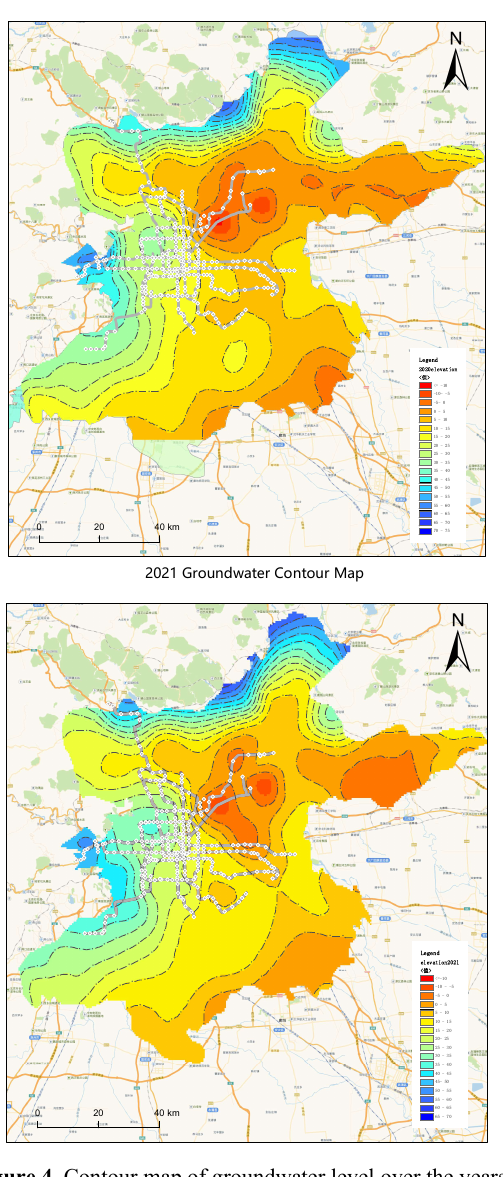
Figure 4. Contour map of groundwater level over the years. Figure 5. Range of groundwater level rise over the